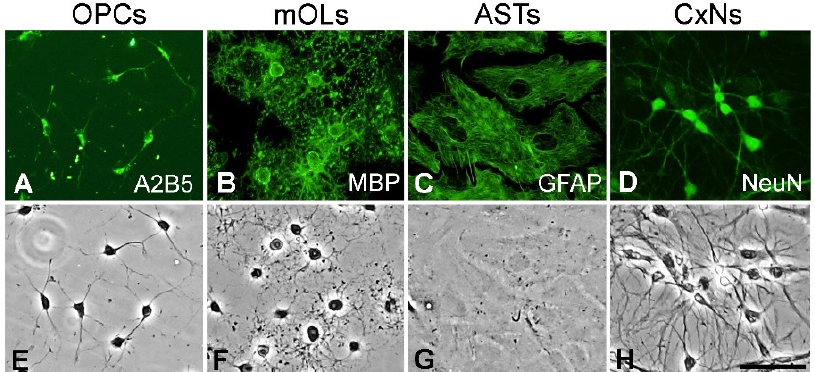
Figure 1. The expression of specific antigens and morphology of primary cells isolated from the brains of neonatal rats. ( A – D ) Specific antigen expression. OPCs, mOLs, astrocytes, and cortical neurons are labeled with specific antibodies. ( E – H ) Morphology. The unique shapes of OPCs, mOLs, astrocytes, and cortical neurons are visualized using phase-contrast microscopy. ASTs = astrocytes, CxNs = cortical neurons. Scale bar = 50 µ